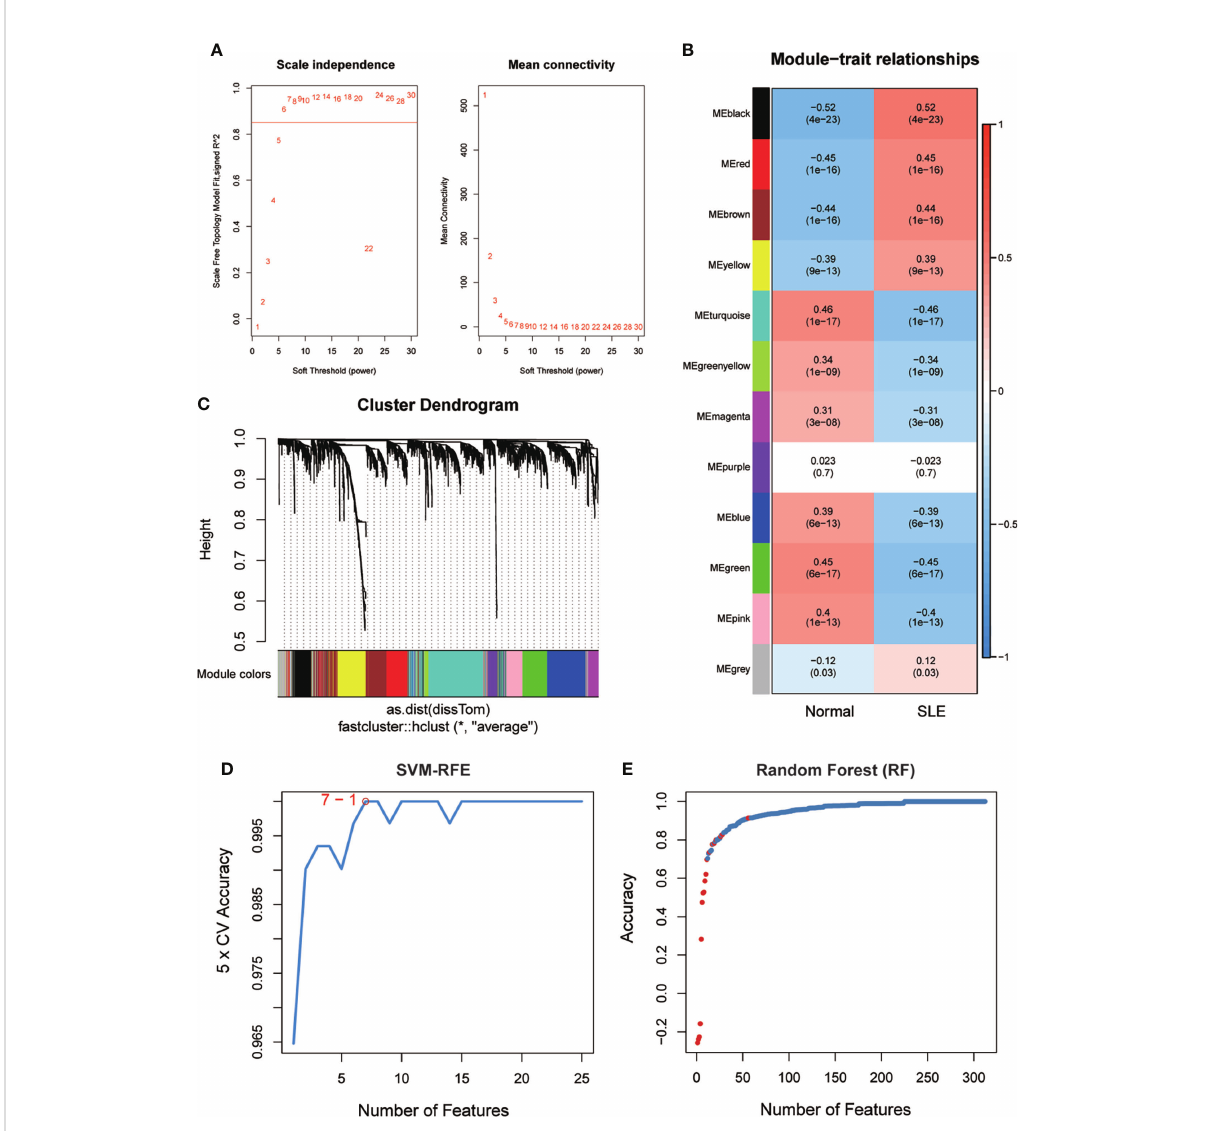
FIGURE 2 SLE biomarker screening. (A) Analysis of the scale-free fi t index and the mean connectivity for various soft-thresholding powers. (B) Relationships of consensus modules with samples. It contains a set of highly linked genes. Each speci fi ed color represents a speci fi c gene module. (C) Clustering dendrogram of differentially expressed genes related to SLE. (D) , (E) Based on support vector machine-recursive feature elimination (SVM -RFE) and random forest (RF) algorithm to screen